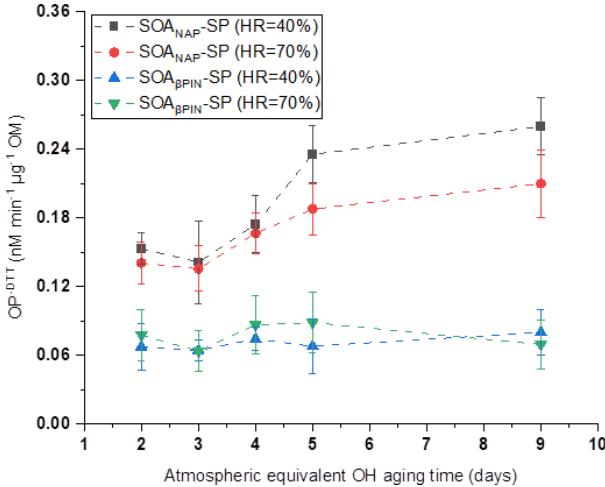
Figure 6. Oxidative potential (OP) of the particles as a function of particle aging time. SOA NAP -SP with a higher photochemical age has a higher OP, whereas photochemical aging of SOA β PIN -SP resulted in no significant change in its